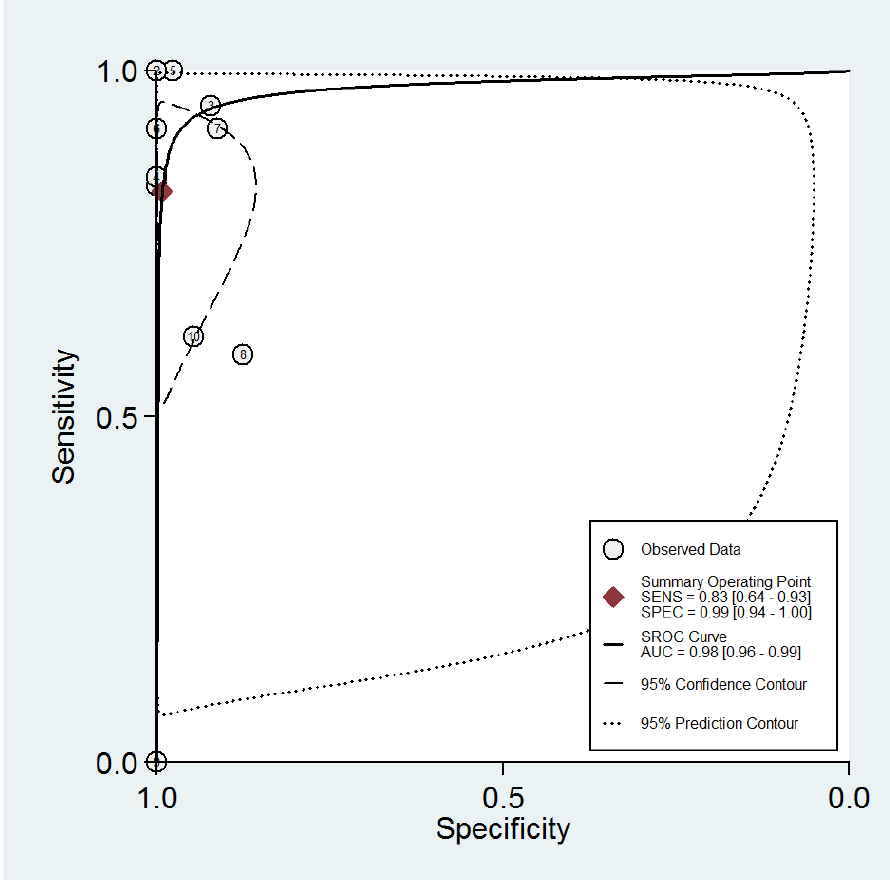
Figure 4. Summary ROC curve for the diagnostic performance of two-dimensional transvaginal ultrasonography to detect uterine septum, showing the sensitivity and specificity for each study and pooled estimation. The dashed line around the summary point estimate (red diamond) represents the 95% confidence region. The dotted line showing the 95% prediction contour corresponds to the predicted performance taking into account all individual studies.